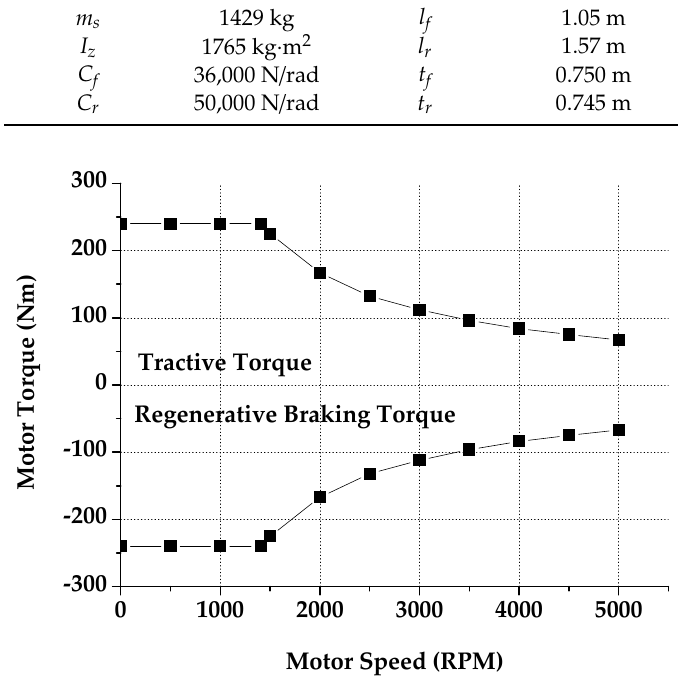
Table 1. Parameter of D-segment SUV in CarSim.